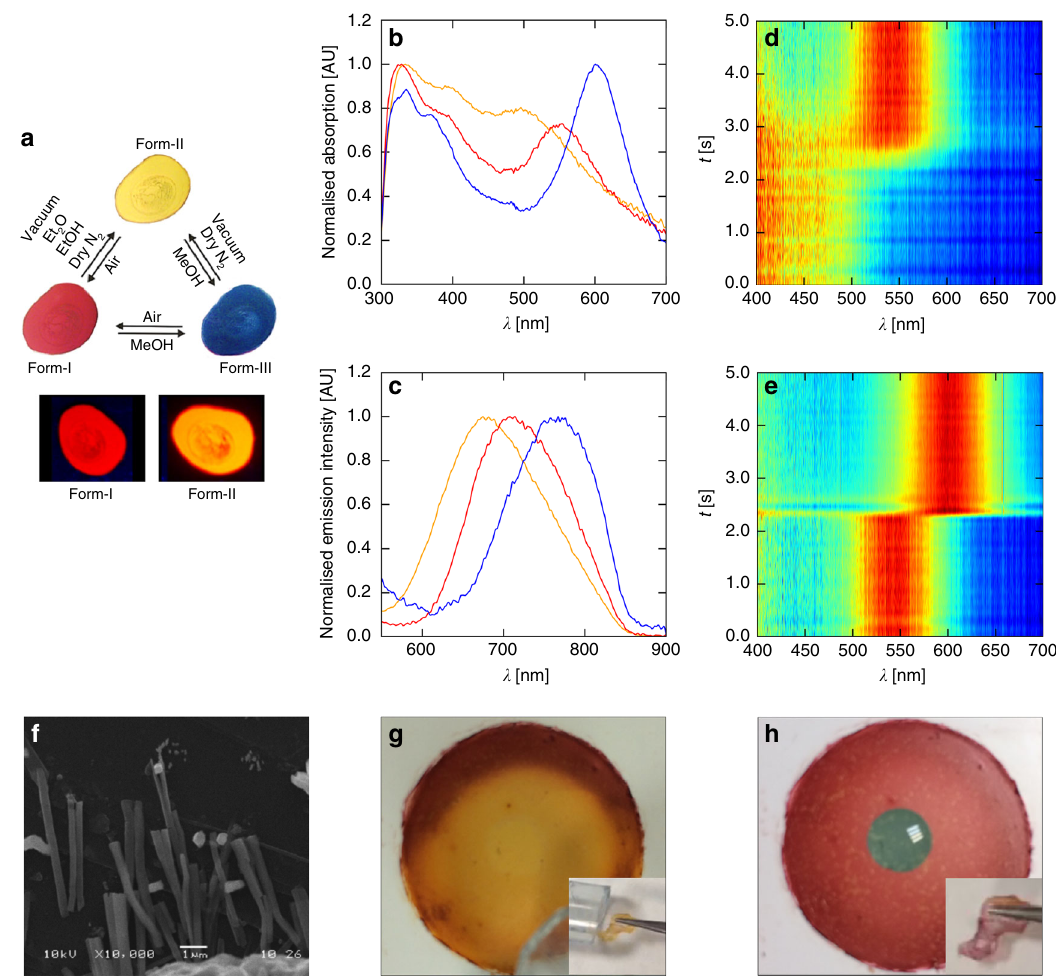
Fig. 3 Solid-state vapochromic switching in Pt-pincer complex 1 . a Images of a thin fi lm of 1 on glass in its hydrated (Form-I), anhydrous (Form-II) and methanolic (Form-III) forms, showing the re fl ective (top) and emissive (bottom) colours. b , c Solid-state absorption ( b ) and emission ( c ; 500 nm excitation) spectra of the three forms. d , e Time-resolved solid-state absorption spectra of 1 during switching between the anhydrous and hydrated ( d ; Form-II → Form-I) and the hydrated and methanolic ( e ; Form-I → Form-III) forms. The colour scale runs from blue (minimum) to red (maximum), and each spectrum used to build the 2D plot is individually normalised to emphasise the shifts in the absorption maxima. The artefact in e during the switching is the point at which the methanol drop was applied to the fi lm. f Scanning-electron micrograph of a similar fi lm to those in a prepared on carbon tape, showing the microstructure. g , h Vapochromic switching in fl exible polymer membranes impregnated with 1 on a support (main) and free standing